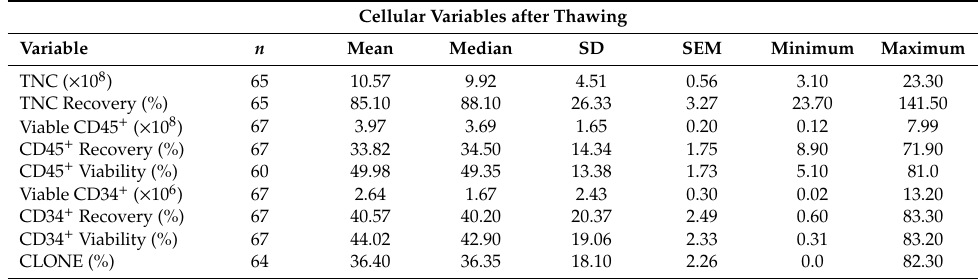
Table 1. Descriptive statistics of 67 distal segments used for confirmatory testing. Total nucleated cell (TNC) were determined using an automated hematology analyzer; CD45 + and CD34 + viable cell count and viability percentage were determined by flow cytometry; and CLONE was determined by cell culture and manual colony count. All UCB units were available for clinical purposes.